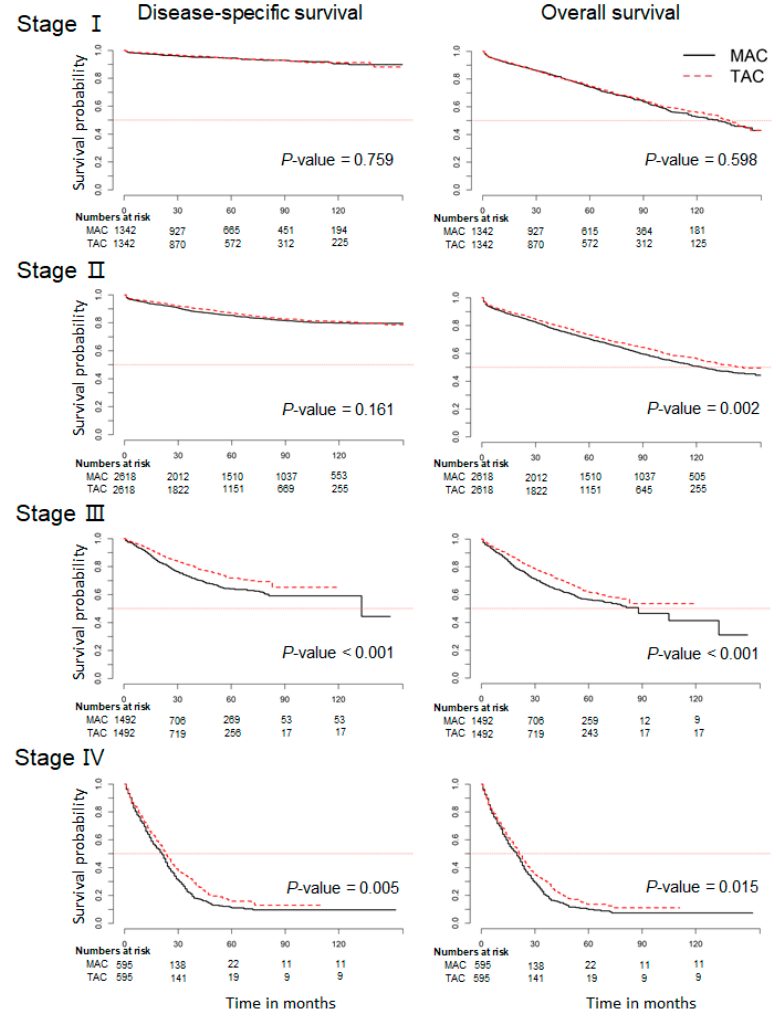
Figure 1. Kaplan–Meier curves of disease-specific and overall survival according to the stage between mucinous (MAC) and traditional colorectal cancer (TAC) in the SEER database.